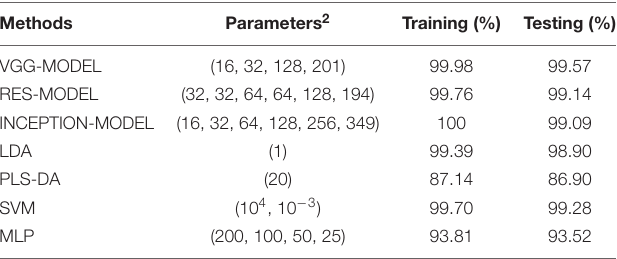
TABLE 2 | The classification accuracies and optimal parameters of all the models on the source